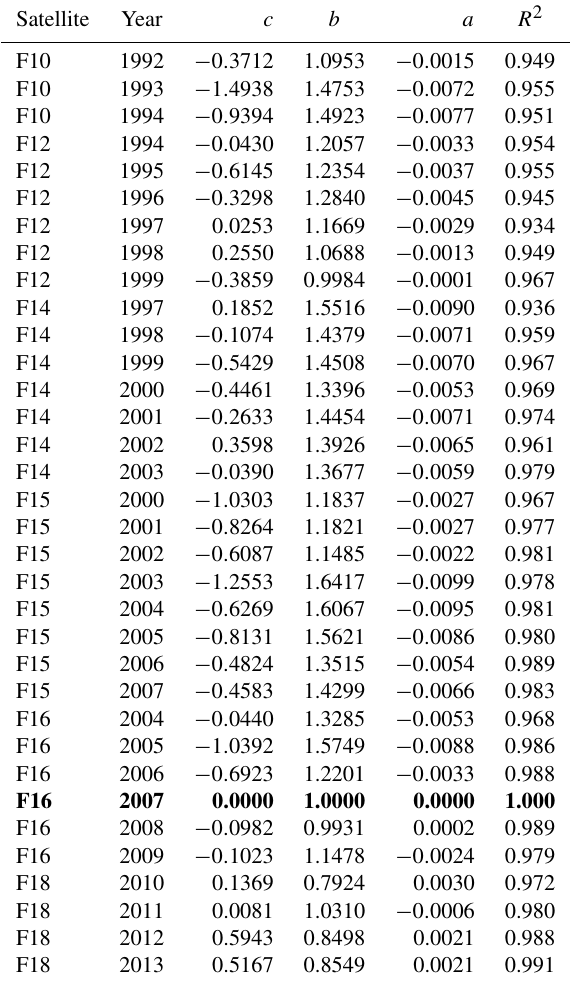
Table 2. DMSP/OLS NTL intercalibration coefficients.